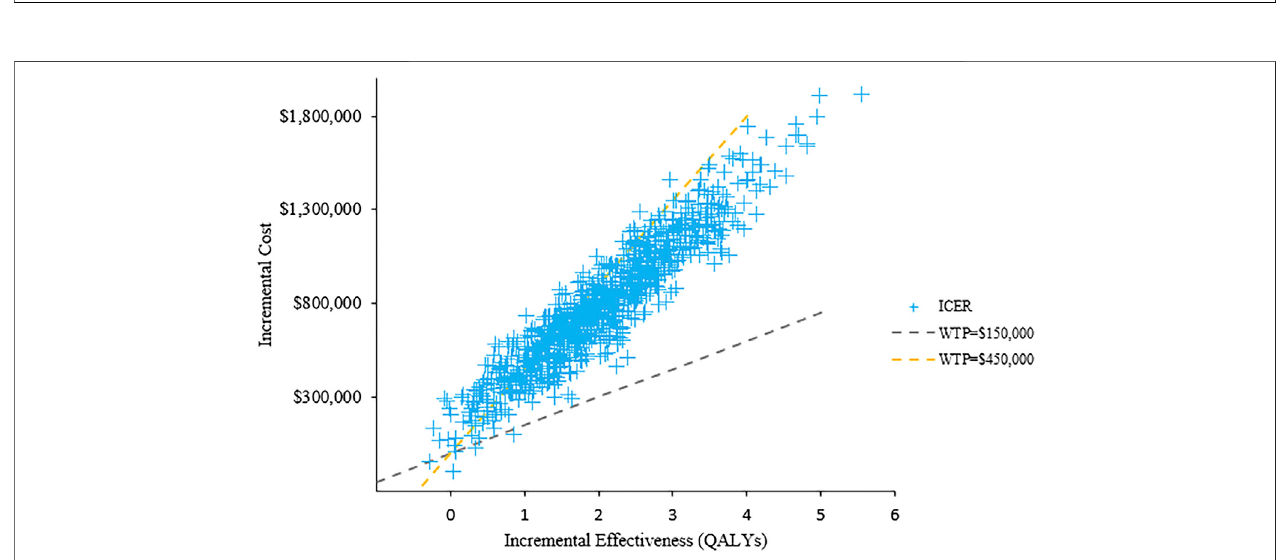
FIGURE 4 | Scatter plot of probabilistic sensitivity analysis. ICER: incremental cost-effectiveness ratio; WTP: willingness to pay.